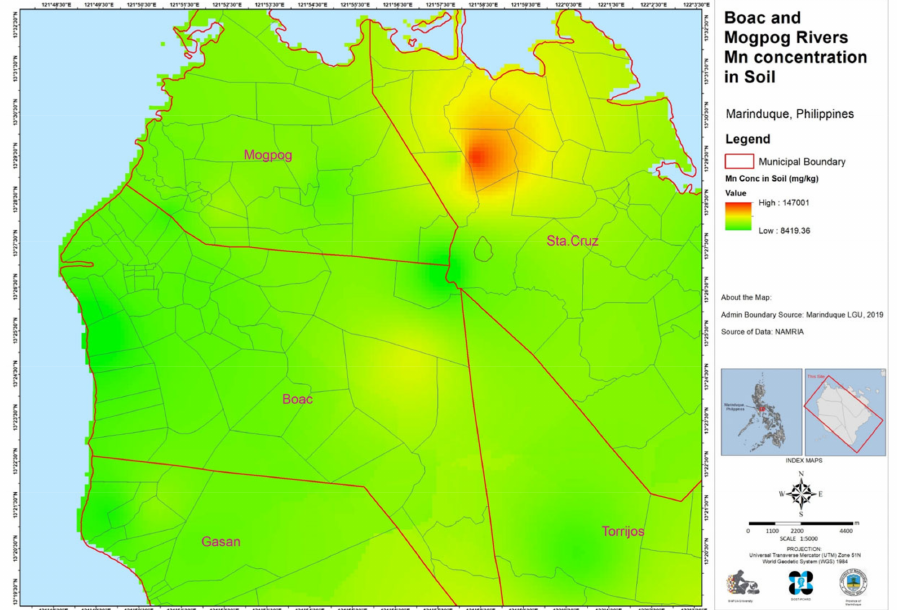
Figure A7. Spatial map for Mn concentration in